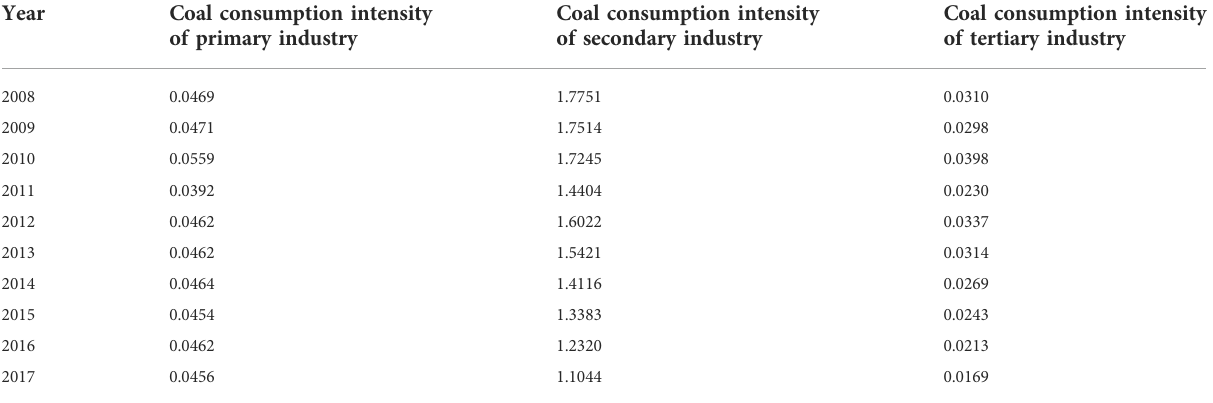
TABLE 8 Coal consumption intensity data of various industries (Unit: 10 4 tons/100 million CNY).